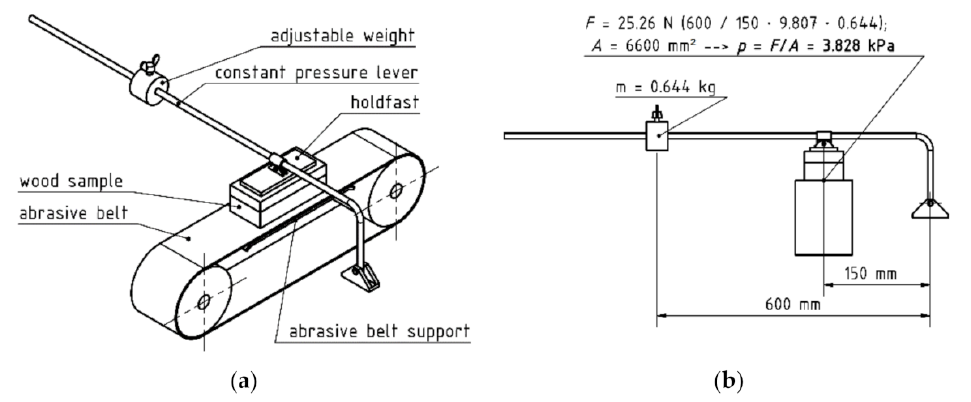
Figure 2. Construction ( a ) and kinematic diagram ( b ) of a laboratory